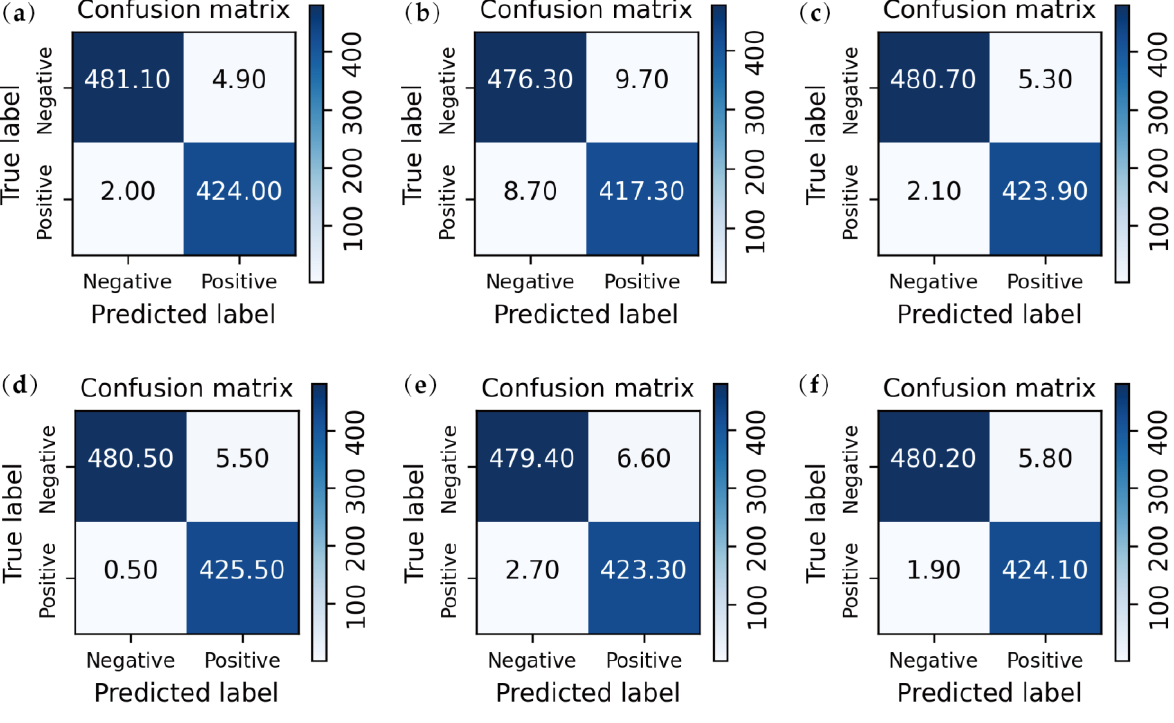
Figure 8. Average confusion matrix. Sub-figures ( a – f ) correspond to models 7–12 in Table 4, respectively. By contrast, Table 5 shows the performance of model 5 is slightly lower than that of models 10 and